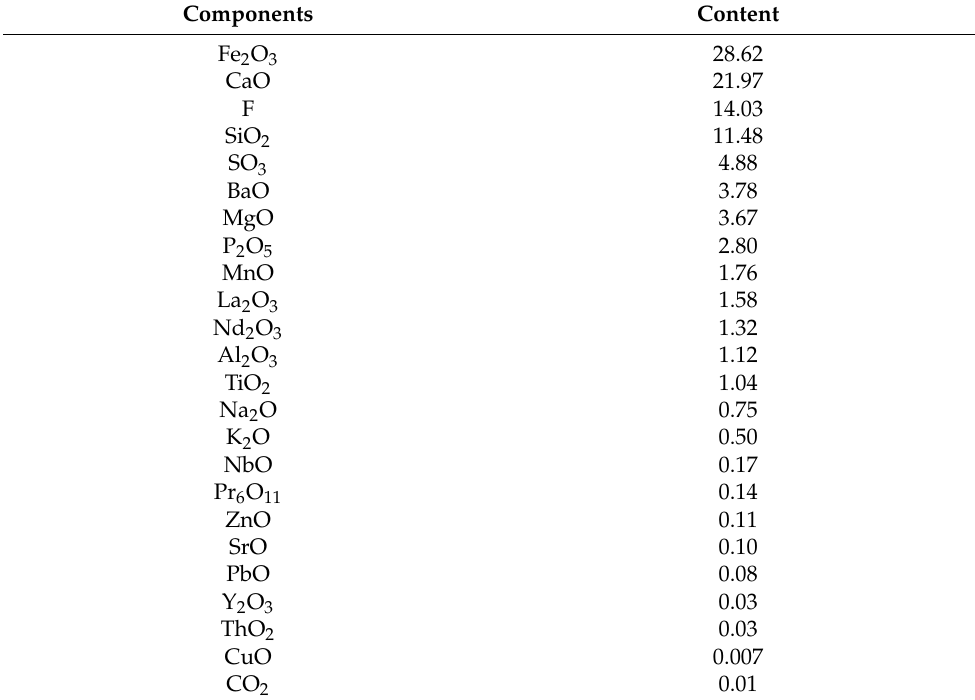
Table 1. Chemical composition of rare-earth tailings (wt